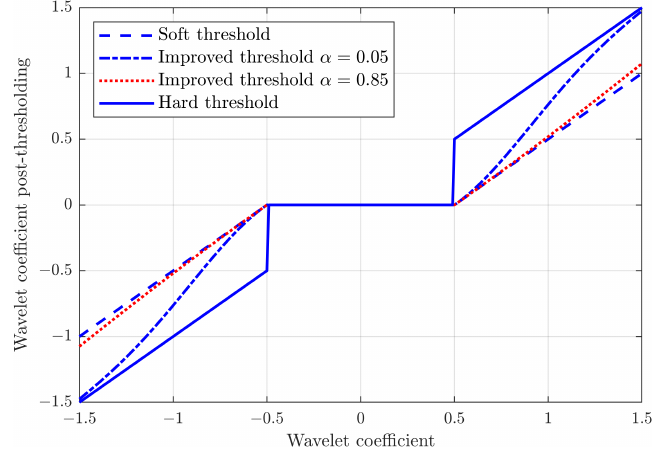
Figure 4. Development of different threshold functions, with a threshold value of th =